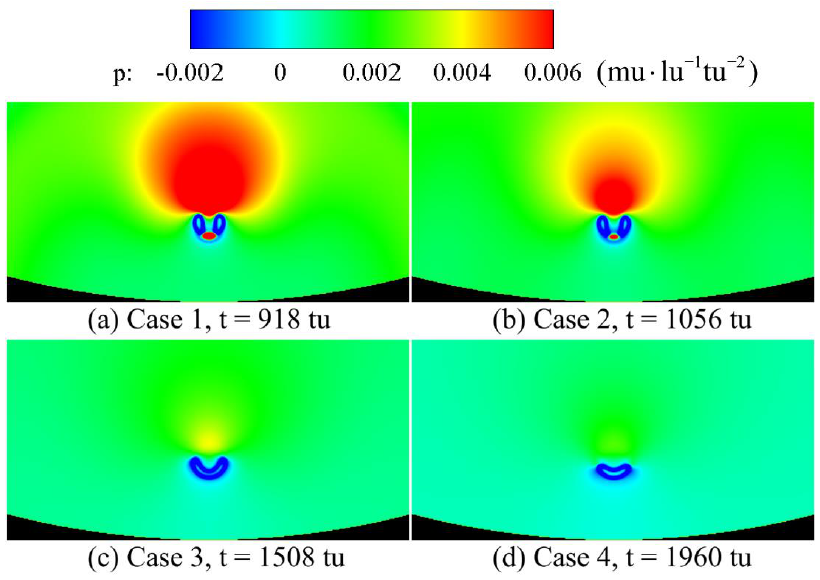
Figure 7. Pressure field of cavitation-bubble collapse Cases 1–4 (Stage 2).